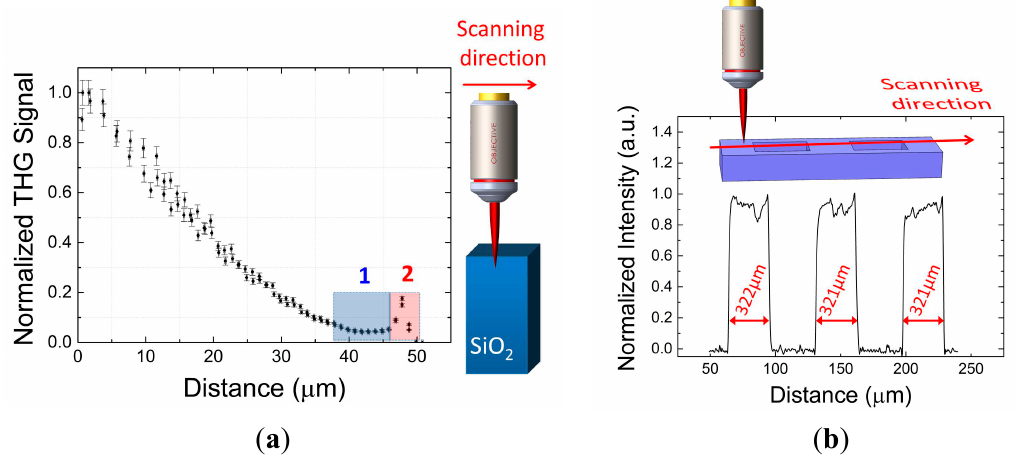
Figure 10. ( a ) Illustration of the formation of the third harmonic generation signal (THG) across the edge of a test sample. Regions one and two are close to the side edge of the material. In region one there is a decay of the signal, which is attributed to internal